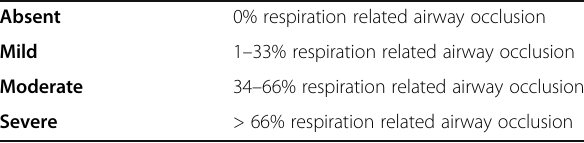
Table 5 Classification of tracheomalacia